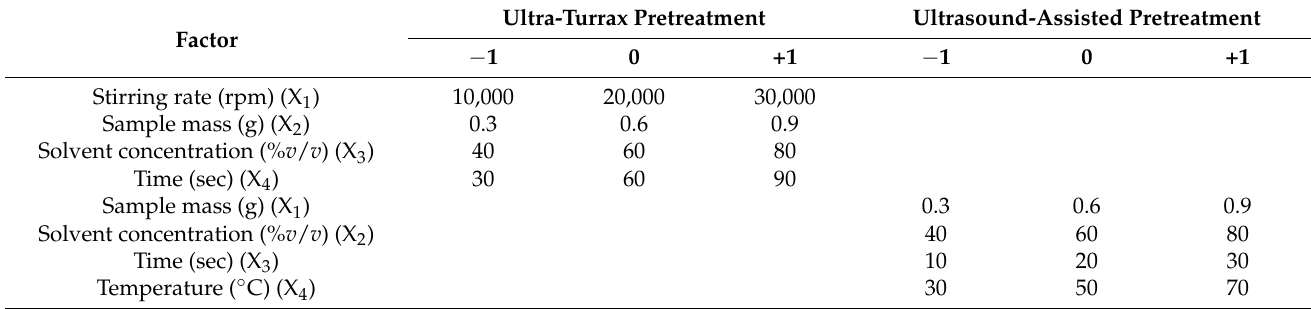
Table 1. Actual and coded values for full factorial experimental